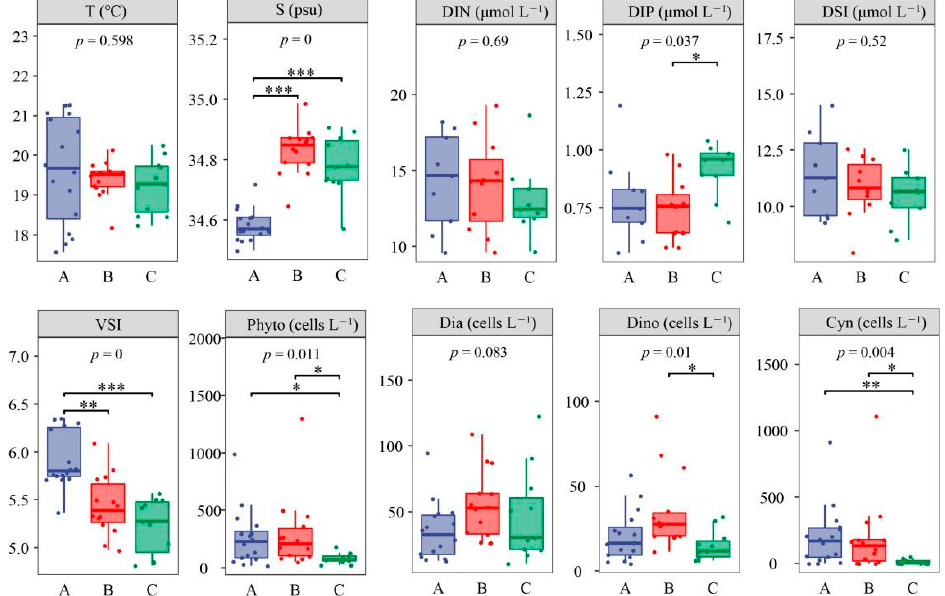
Figure 7. The differences of environmental factors and phytoplankton in three regions (* p < 0.05; ** p < 0.01; *** p < 0.001, Kruskal–Wallis test, Temperature: T; Salinity: S; Dissolved Inorganic Nitrogen: